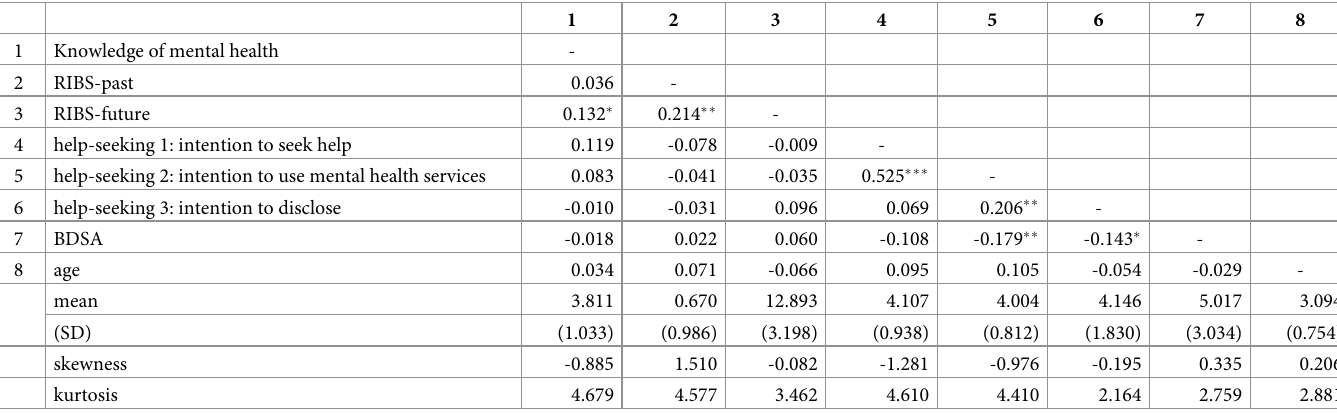
Table 2. Pearson’s correlation coefficients, mean, SD, skewness and kurtosis of observed